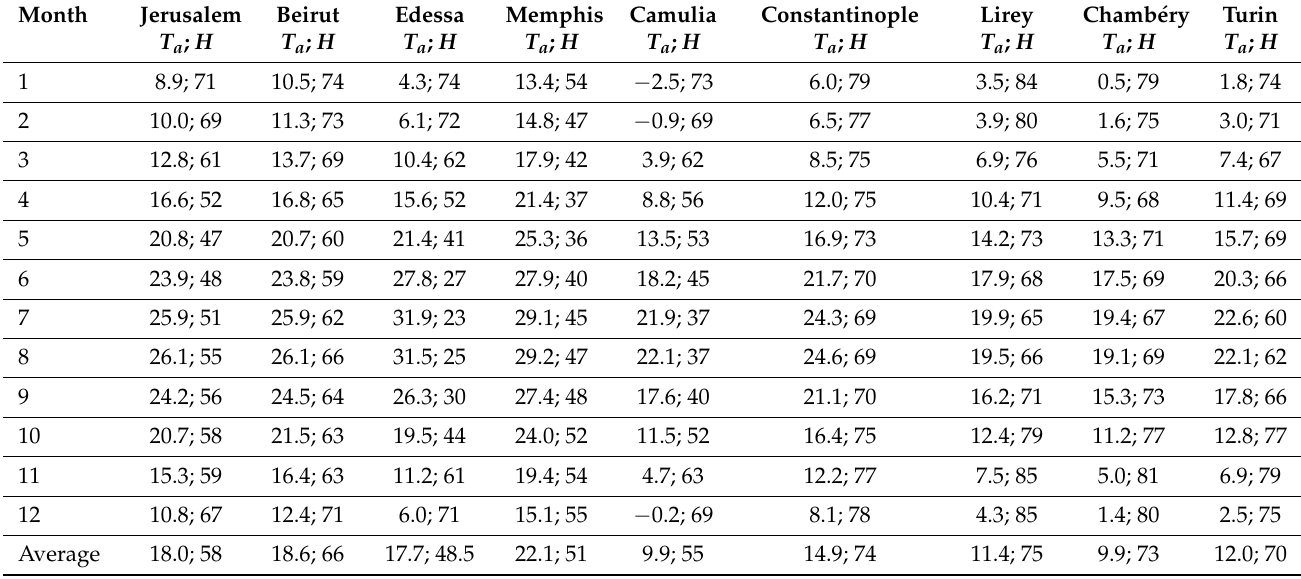
Table 2. Monthly mean temperatures T a ( ◦ C) and relative humidity H (%) of the localities indicated in Table 1. The last row reports average values